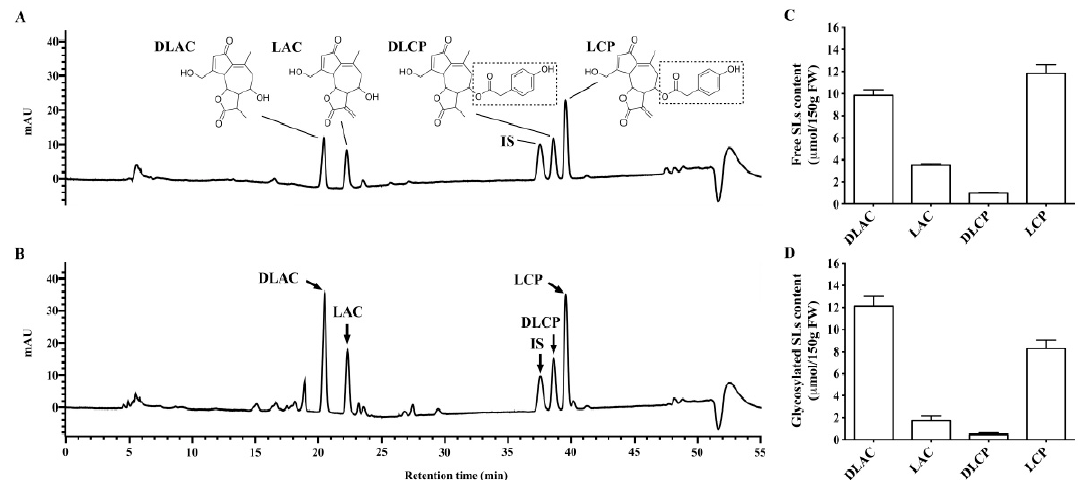
Figure 1. Characterization and quantification of sesquiterpene lactones in Brussels / witloof chicory. ( A , B ) Representative chromatographic profiles of sesquiterpene lactones in Brussels / witloof chicory treated without ( A ) or with cellulase ( B ). Santonin was served as an internal standard. ( C , D ) The content of free ( C ) or glycosylated ( D ) sesquiterpene lactones from 150 g of Brussels / witloof chicory. Values are the means ± SEM, n = 6. SLs, sesquiterpene lactones; LAC, lactucin; DLAC, 11 β ,13-dihydrolactucin; LCP, lactucopicrin; DLCP, 11 β ,13-dihydrolactucopicrin; IS, internal standard; FW, fresh weight. Dotted box, ester of 4-hydroxyphenylacetic acid.